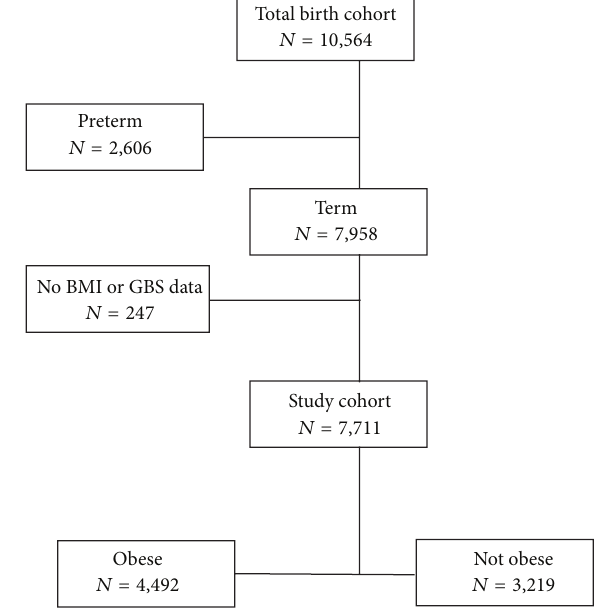
Figure 1: Flowchart of study subjects. Table 1: Characteristics of study subjects ( 𝑁 =